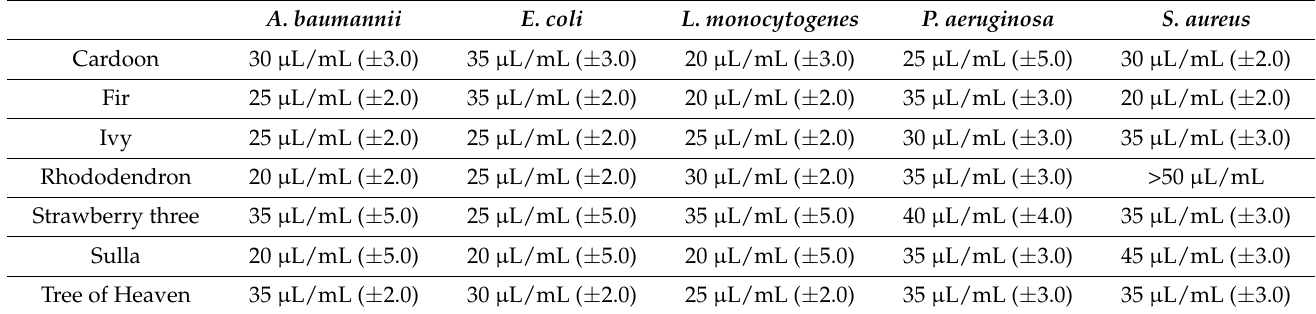
Table 2. Minimal inhibitory concentration (MIC, µ L/mL) of the monofloral honeys, needed to block the growth of the five bacterial strains, evaluated by the resazurin test. Data are mean values of three determinations ( ±